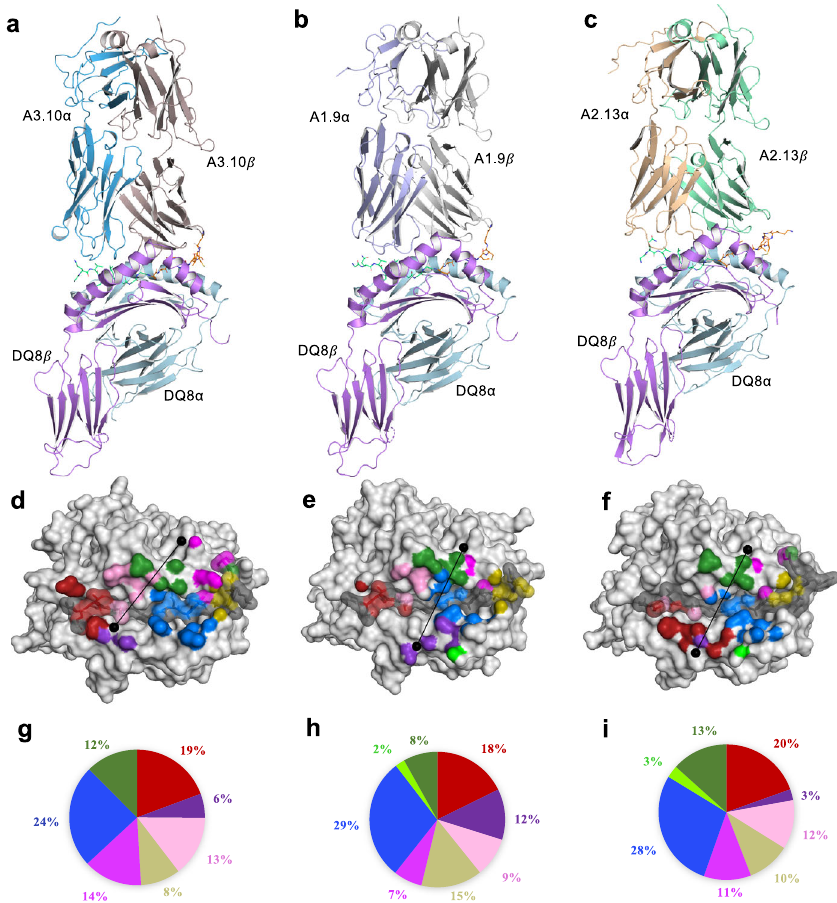
Fig. 4 Structural overview of proinsulin C-peptide-responsive TCR-HLA-DQ8-HIPL11C ternary complexes. a – c Cartoon representation of TCR bound to HLA-DQ8-HIPL11C. The HLA-DQ8 α -chain is coloured in neon, and the HLA-DQ8 β -chain in light cyan. The TCRs are coloured as follows: a TCR A3.10 α - chain in sky-blue; β -chain in light brown; b TCR A1.9 α -chain in mauve; β -chain grey; c TCR A2.13 α -chain in wheat; β -chain in light green. The TCR CDR 1 α , 2 α , 3 α loops, α -framework, CDR 1 β , 2 β , 3 β loops and β -framework are coloured red, purple, pink, neon-green, gold, magenta, blue, and green, respectively. HIP peptide bound in HLA-DQ8 binding cleft is coloured in lime-green (C-pep portion), and orange (IAPP2 portion). d – f Atomic footprints of TCR A3.10, A1.9, and A2.13 on the surface of HLA-DQ8-HIPL11C, respectively. HLA-DQ8 α - and β -chain are coloured in light-grey, whilst HIPL11C is in dark grey. The CDR loops colours described above. TCR footprint colours are in accordance with the nearest TCR contact residues. The TCRs ’ V α and V β centre of mass position are shown as black dots, with the line approximating their docking angle. g – i The pie charts present the relative contribution of each CDR loop, α -, and β -framework of TCR A3.10, A.19 and A2.13 to the surface of HLA-DQ8-HIPL11C,